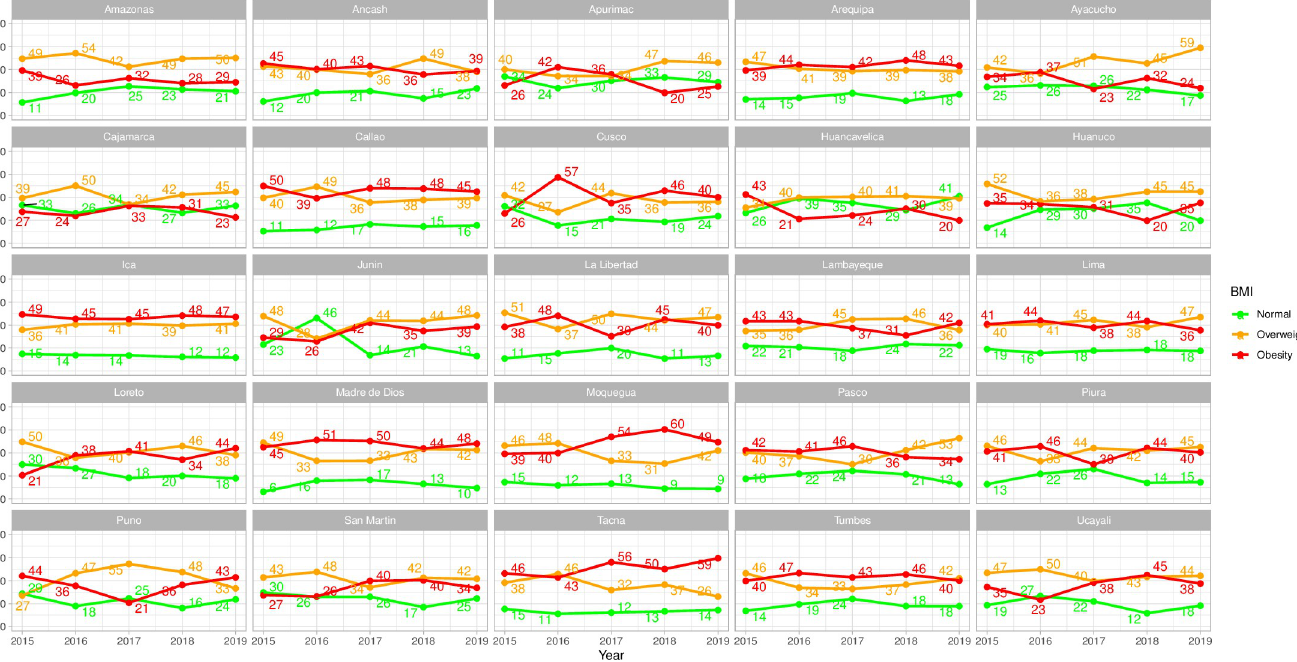
Fig 4. Sub-national time trends of glucose test by body mass index categories in